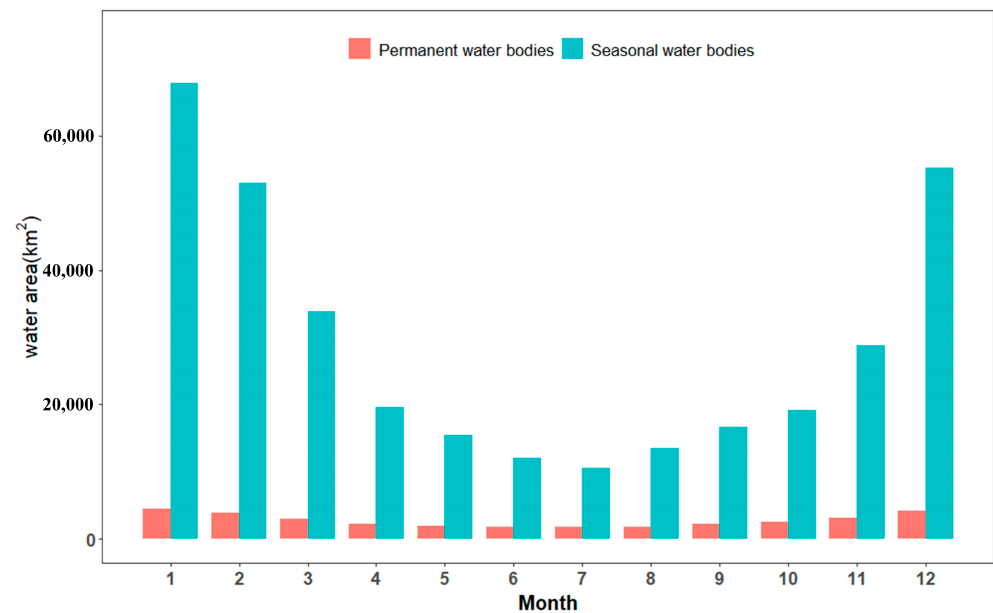
Figure 7. The monthly variation of surface water bodies for 1984 to 2019 in the TRB.